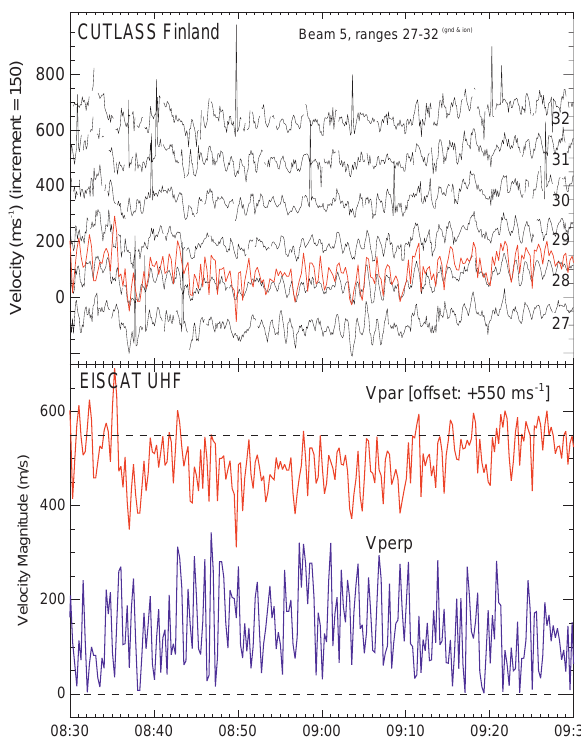
Fig. 3. The top panel illustrates CUTLASS velocities from beam 5 of the Hankasalmi radar, ranges 27–32. The bottom panel illus- trates the two field perpendicular components of the EISCAT radar tristatic velocity measurements, resolved parallel and perpendicular to the direction of CUTLASS beam 5, range gate 28. The paral- lel velocity is superimposed in red on the top panel to allow a di- rect comparison with CUTLASS measurements of the wave event shown in Figs. 2 and 3, using beam 5, range gate 28 for the interval